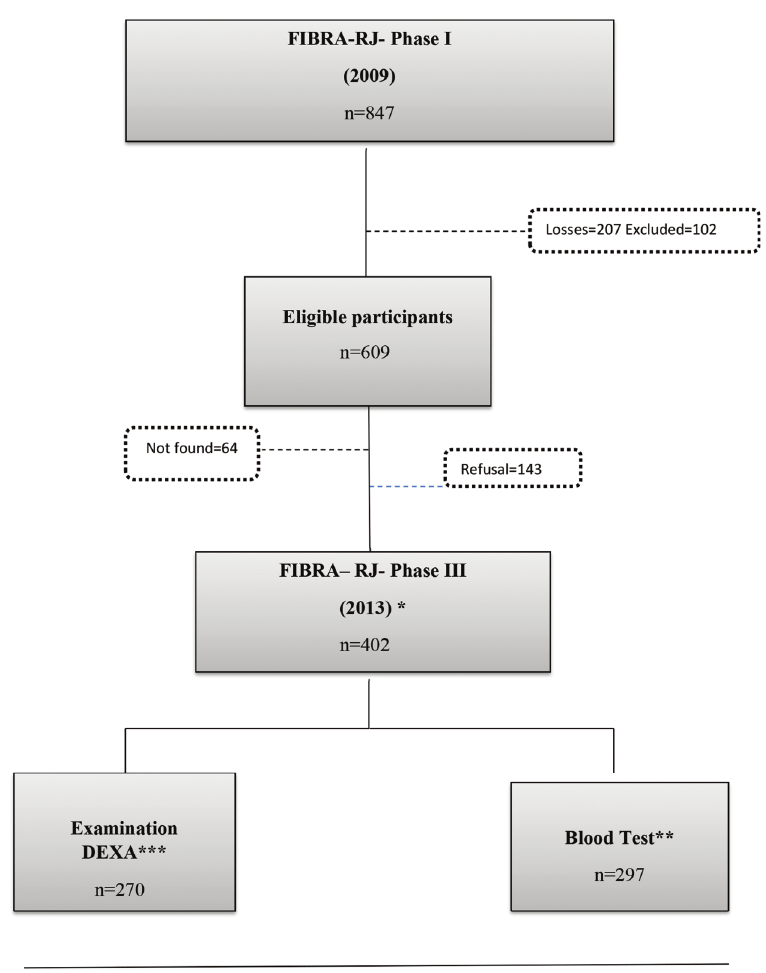
Figure 1 - Diagram for selecting the final sample of the FIBRA RJ-III study. *GERONLAB researchers conducted a face-to-face interview with the participant at their residence and obtained anthropometric measurements. **Visit to the Human Aging Laboratory for blood tests. ***Visit of the elderly person to the Interdisciplinary Nutritional Assessment Laboratory to assess body composition through DEXA: Exclusion=4, not found=4, refusal=123, and deceased during the